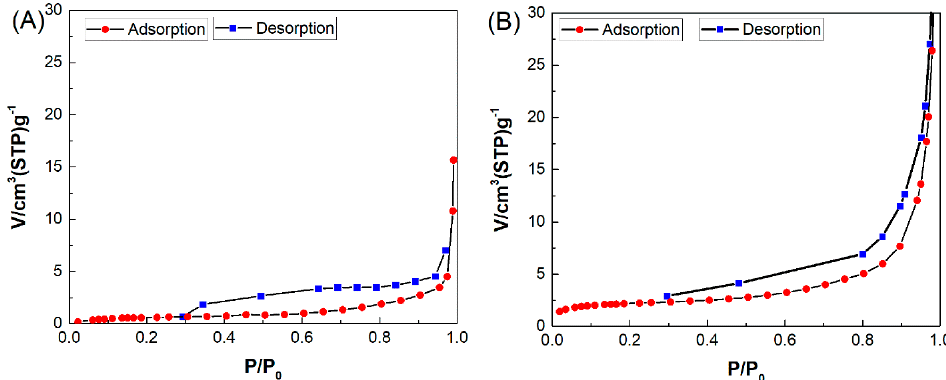
Figure 5. N 2 adsorption/desorption isotherms of Fe 2 O 3 ( A ) and CMT-g-PANI@Fe 2 O 3 ( B ).